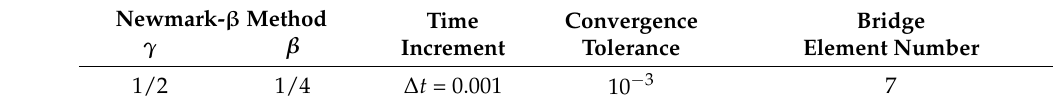
Table 4. The simulation parameters.